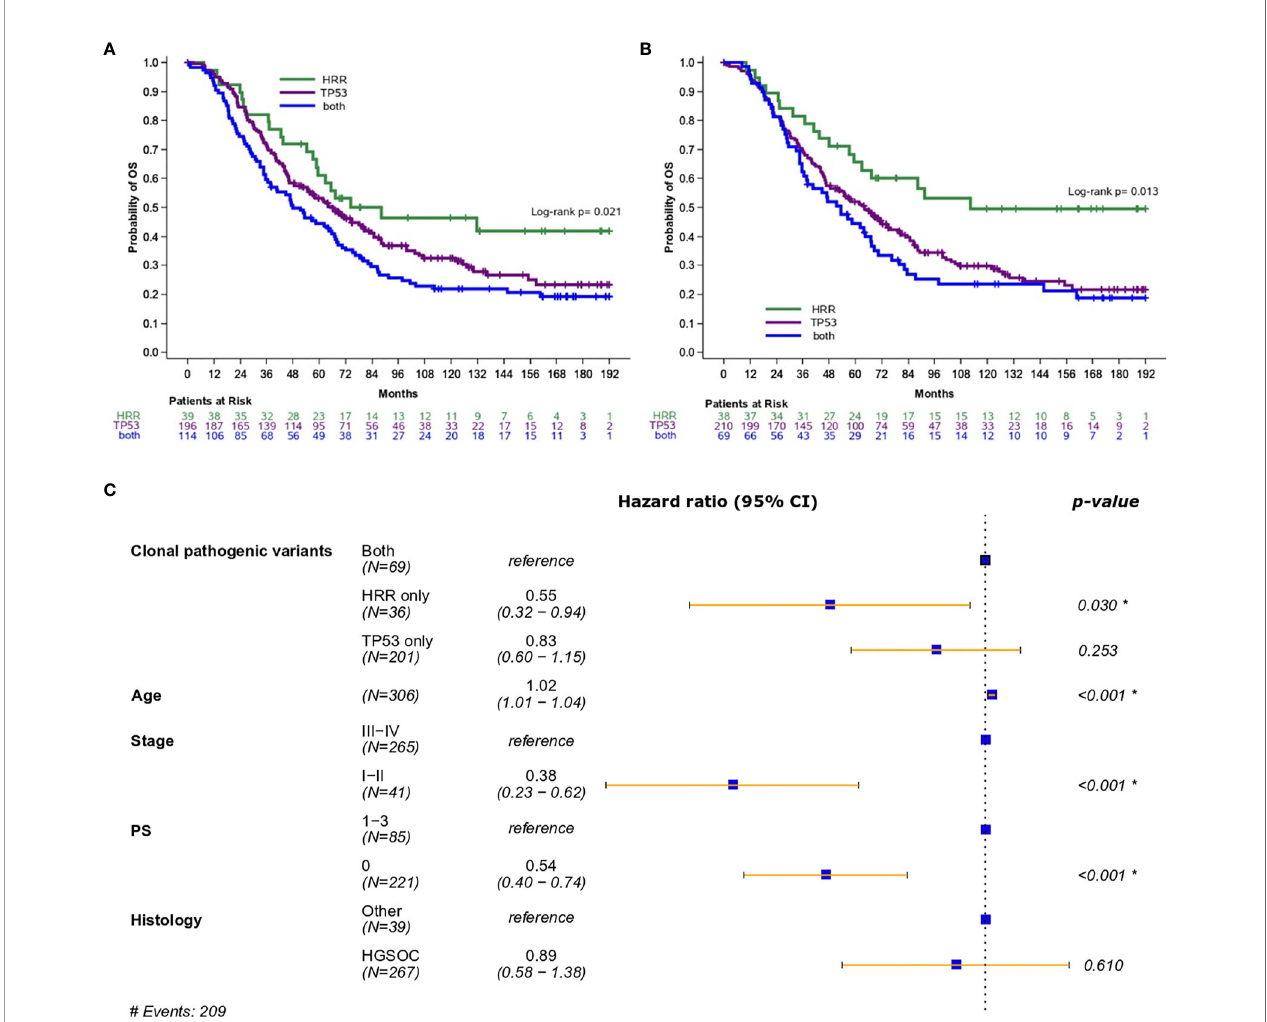
FIGURE 2 | (A) Overall survival based on the presence of HRR and/or TP53 pathogenic variants (excluding mucinous tumors). (B) Overall survival based on the presence of HRR and/or TP53 clonal pathogenic variants (excluding mucinous tumors). (C) Forest plot of hazards ratios showing the risk of death for patients with HRR and/or TP53 clonal pathogenic variants upon adjustment for clinicopathological parameters (excluding mucinous tumors). *Statistically signi fi cant